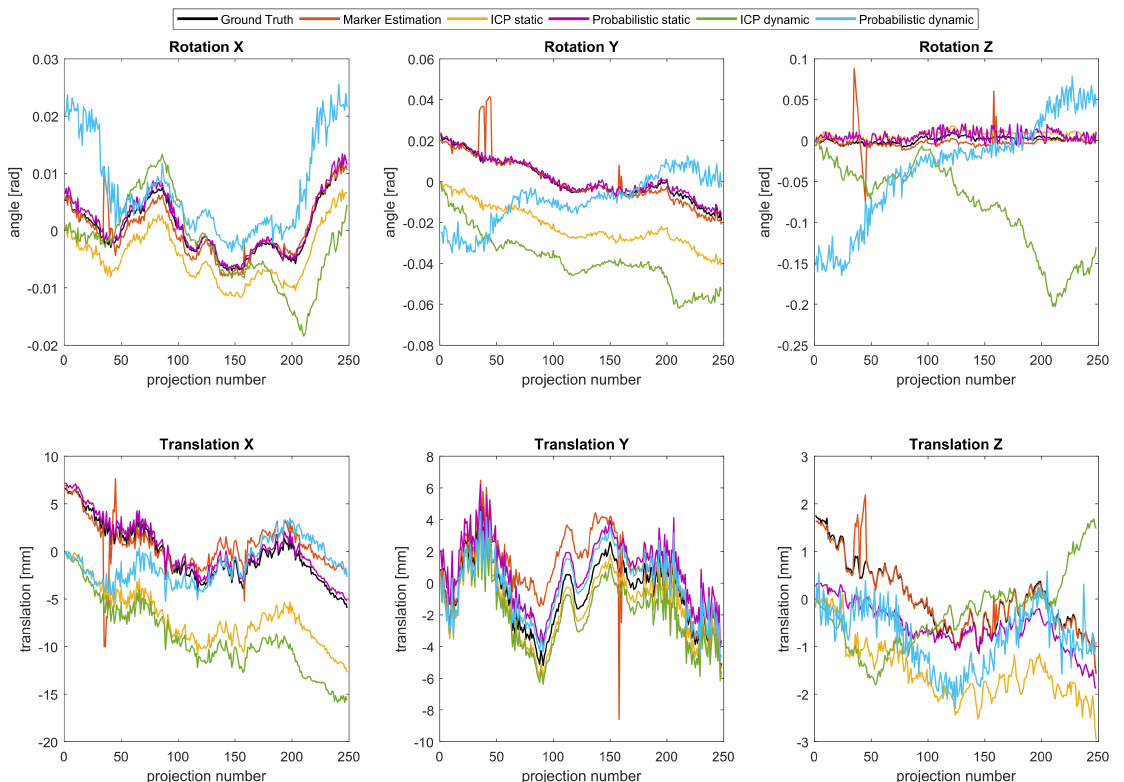
Figure 6. Estimated motion signals. The rotation parameters are Euler angles calculated from the estimated rotation matrices in order to simplify the